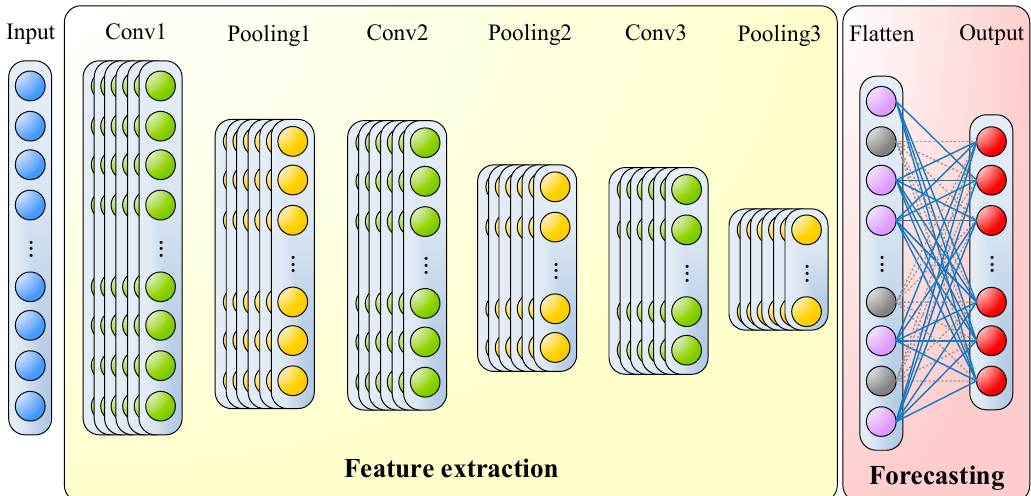
Figure 4. The DeepEnergy structure.